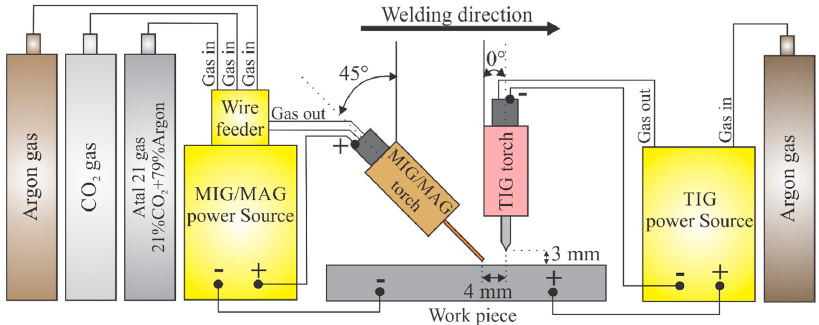
Figure 1. Schematic diagram of TIG-MIG/MAG hybrid welding.